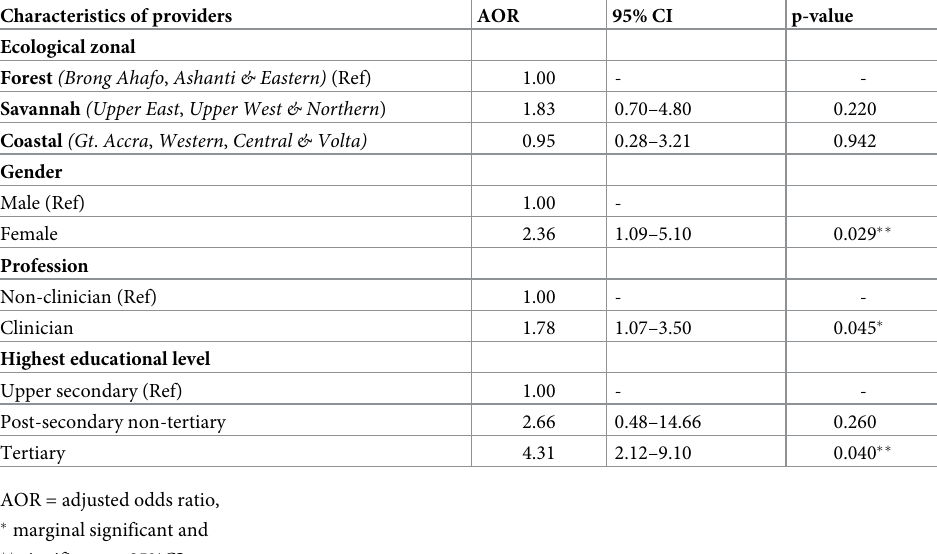
Table 6. Multivariable logistic regression between implementation fidelity level and background factors with dis- trict hospital (random) effect. Characteristics of providers